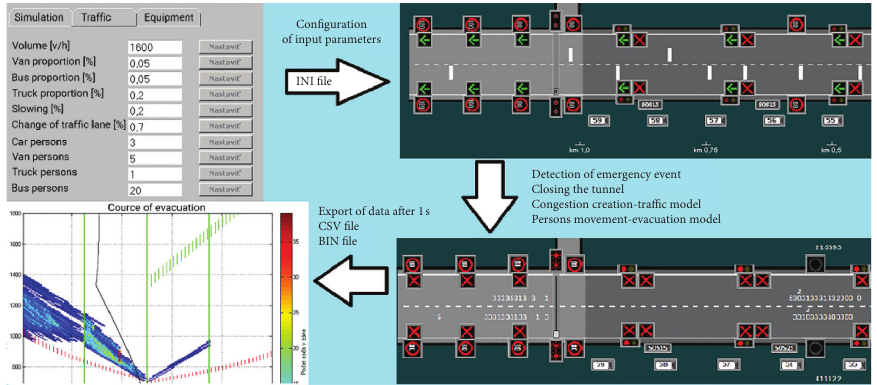
Figure 14: TuSim, simulation